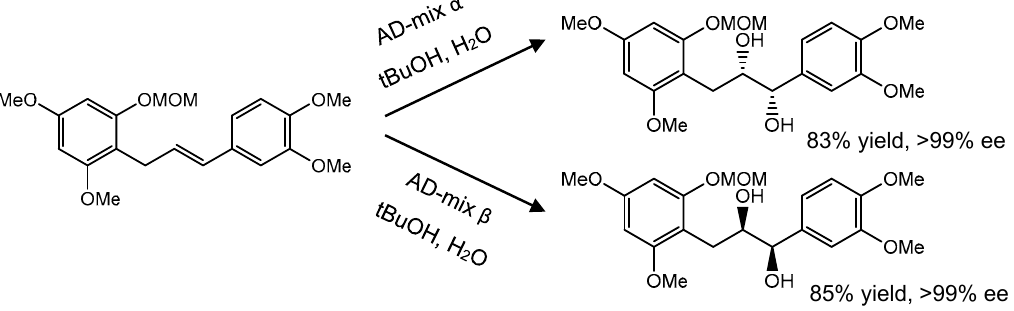
Figure 18. Sharpless asymmetric dihydroxylation to achieve chiral centers.